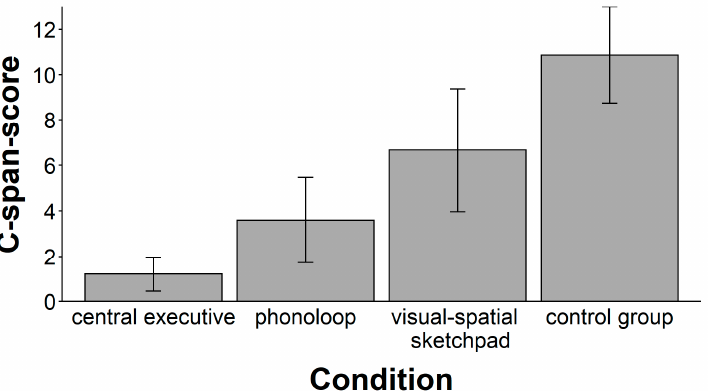
Figure 3. Mean performance in the computation span task in the four different groups. Whiskers indicate 95% confidence intervals.